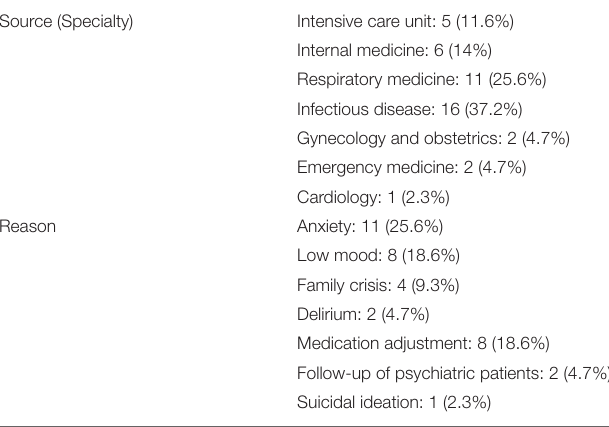
TABLE 3 | Referral features ( n =